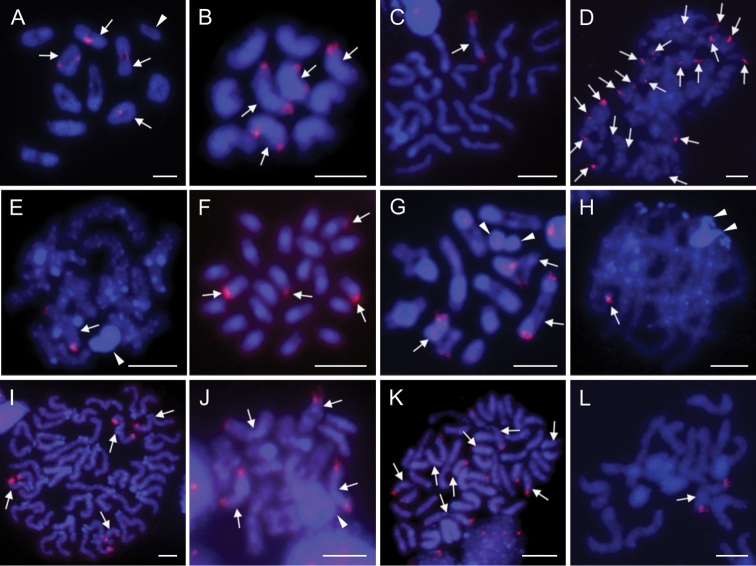
Chromosomes of entelegyne spiders from South Africa after FISH with 18S rDNA probe (red signal). Arrows point on bivalents with signals (A, E, G, H, J), certain chromosomes with signals (B, C, F, I, K, L), or certain signals (D) AArgyrodes
cf.
convivans (Theridiidae), diplotene BArgyrodes
cf.
convivans, half of metaphase II (without sex chromosomes), note distal (opposite centromere) positions of loci COlios sp. from South Africa (Sparassidae), metaphase II, one sister cell without sex chromosomes, note distal position of locus DOlios sp. from Namibia (Sparassidae), metaphase II, signals at distal parts of acrocentric chromosomes EAfroceto
plana (Trachelidae), diplotene FZelotes
sclateri (Gnaphosidae), mitotic metaphase GPlatyoides
walteri (Trochanteriidae), diplotene HCheiramiona
kirkspriggsi (Cheiracanthiidae), pachytene, with distal signal on one bivalent IThyenula
haddadi (Salticidae), metaphase II, distal signals on two chromosome pairs JAnyphops sp. (Mossel Bay) (Selenopidae), diplotene KSelenops sp. 1 (Pongola Reserve) (2n♂ = 26) (Selenopidae), metaphase II, two sister cells LSelenops sp. 2 (Selenopidae), half of metaphase II. Arrowheads indicate sex chromosomes, where distinguished. Scale bars: 5 μm.